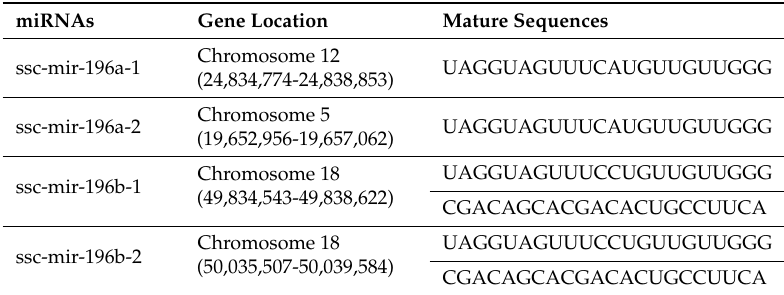
Table 2. miR-196a genes and mature